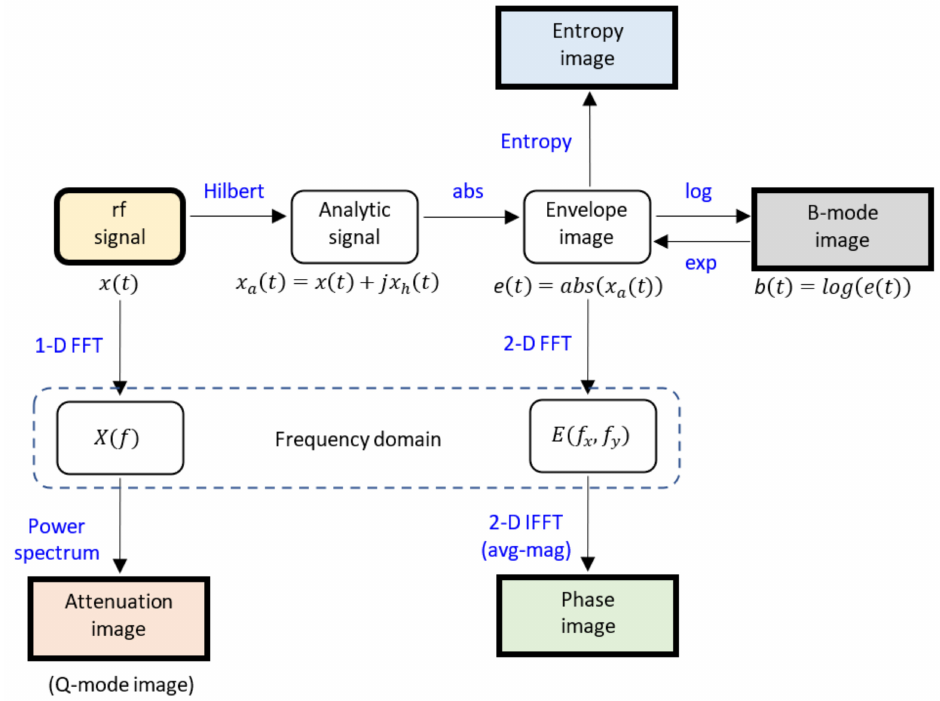
Figure 2. Overall scheme of signal processing techniques using RF